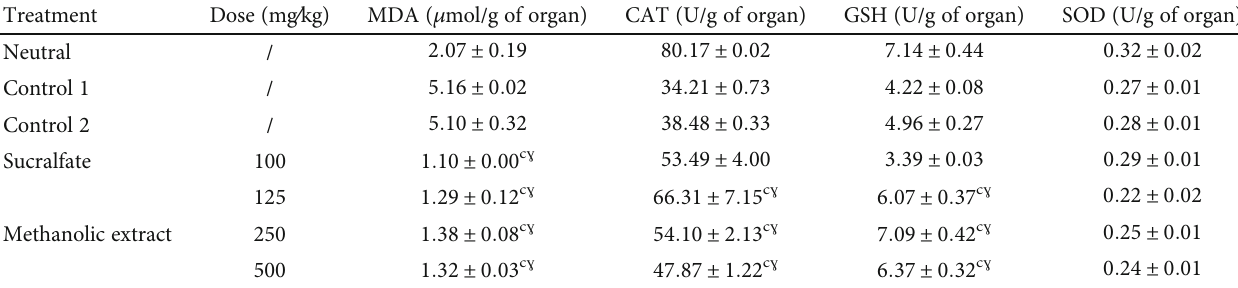
Table 5: E ff ect of methanolic extract of D. benthamianus stem bark on some parameters of oxidative stress in ethanol-induced gastric lesions in rats.